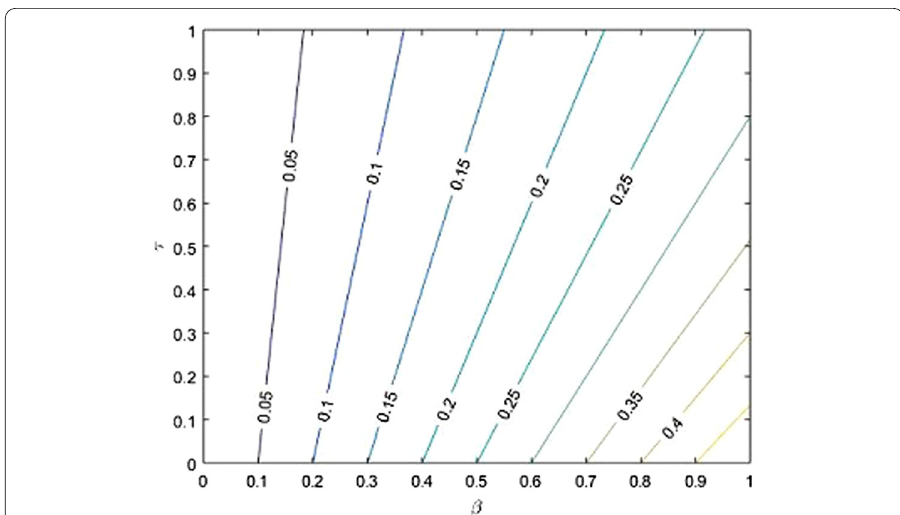
Figure 7 Contour plot of the reproductive number as functions of β and